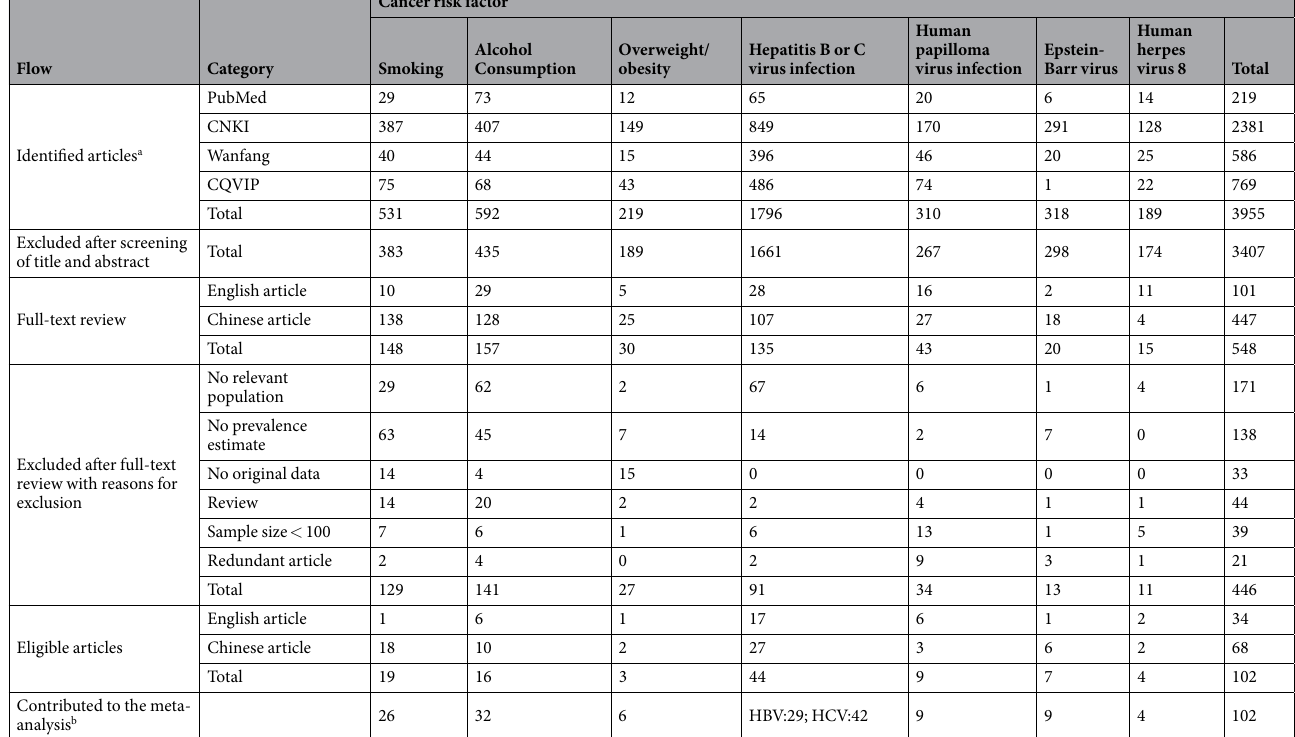
Table 1. The process for selection of studies, by cancer risk factor. a Date searched from database inception to February 29, 2016 for all cancer risk factors, except for hepatitis B or C virus infection (January 1, 2013– February 29, 2016). b Including eligible articles identified from both the specific risk factor and other risk